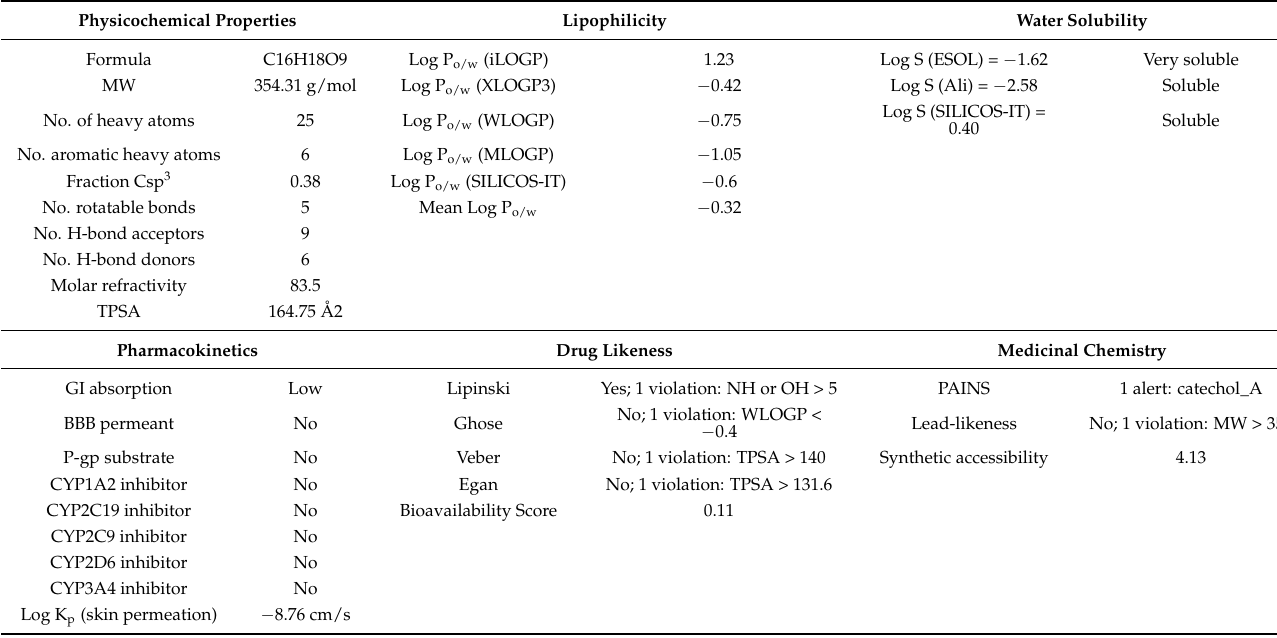
Table 6. Predicted ADME for cryptochlorogenic